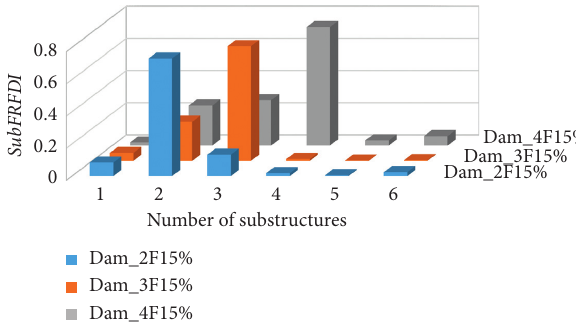
Figure 7: SubFRFDI values for cases Dam_2F15%, Dam_3F15%, and Dam_4F15%.